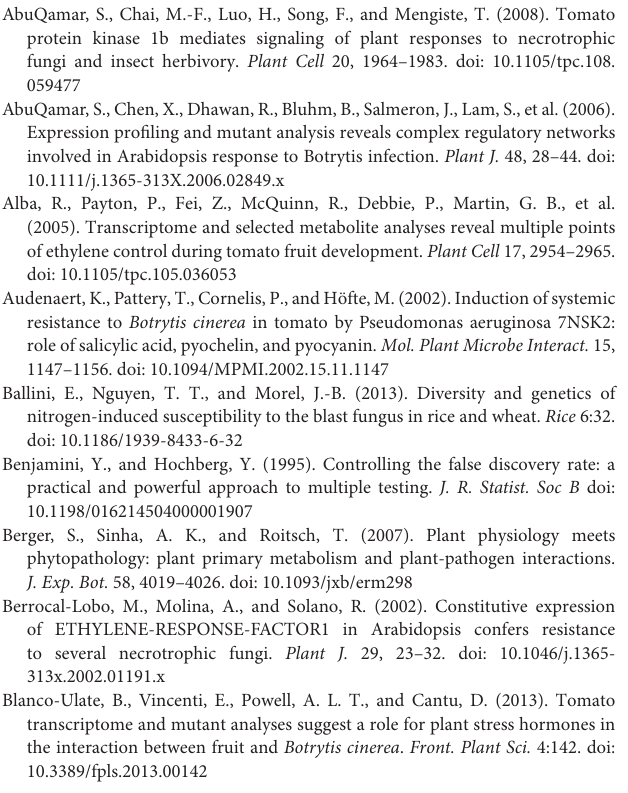
Figure S2 | Fungal growth quantification over a B. cinerea infection time-course. The abundance of the fungus was quantified by qPCR amplification of cutA (see Materials and Methods) in infected leaves samples (A) , and MG (B) and RR (C) fruits. Different letters indicate significant differences among treatments ( p ≤ 0.05 ; error bars indicate SEM; n = 3 ). Figure S3 | ANOVA analysis of microarray gene expression data. The number of genes with significant factors obtained by Two-way ANOVA analysis of global expression data is represented ( p < 0.01 ), employing the SUNGEAR tool (Poultney et al., 2007). The triangle and its vertices represent the analyzed factors: B. cinerea (B), N conditions (N) and the interaction between these two factors (N/B). Circles (and their respective size) represent the number of genes controlled by the different factors, as indicated by the arrows around the circles. Table S1 | Microarray expression data for genes with N/B ANOVA model (adjusted p < 0.01 ). The table includes the Affymetrix probes, the tomato accessions (ITAG2.4, Sol Genomics Network, https://solgenomics.net) and their annotations, Arabidopsis (TAIR, http://arabidopsis.org) or GeneBank accessions, the p -value adjusted by FDR and the log2-fold changes of the comparison between B. cinerea infected and mock-treated sample (B/M) in each N-conditions (2, 6, and 12mM nitrate). Table S2 | Microarray expression data for genes that are either up- or down-regulated by the B. cinerea infection in comparison to mock-inoculated plants grown in N-limiting conditions (2mM nitrate) (ANOVA; Rank-products, p < 0.05 ). The table includes the Affymetrix probes, the tomato accessions (ITAG2.4, Sol Genomics Network, https://solgenomics.net) and their annotations, Arabidopsis (TAIR, http://arabidopsis.org) or GeneBank accessions, the p -value, Gene Ontology and the log2-fold changes of the comparison between B. cinerea infected and mock-treated sample (B/M) grown in N-limiting conditions (2mM nitrate).